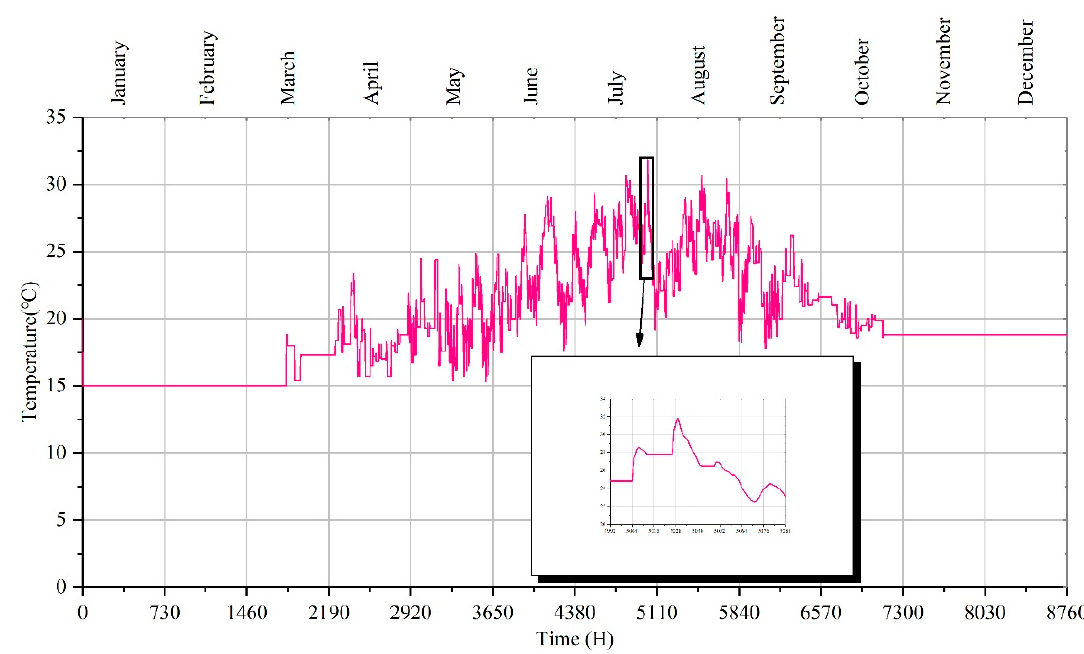
Figure 17. The outlet temperature of cooling tower during a year. Table 10. Produced energy in cooling